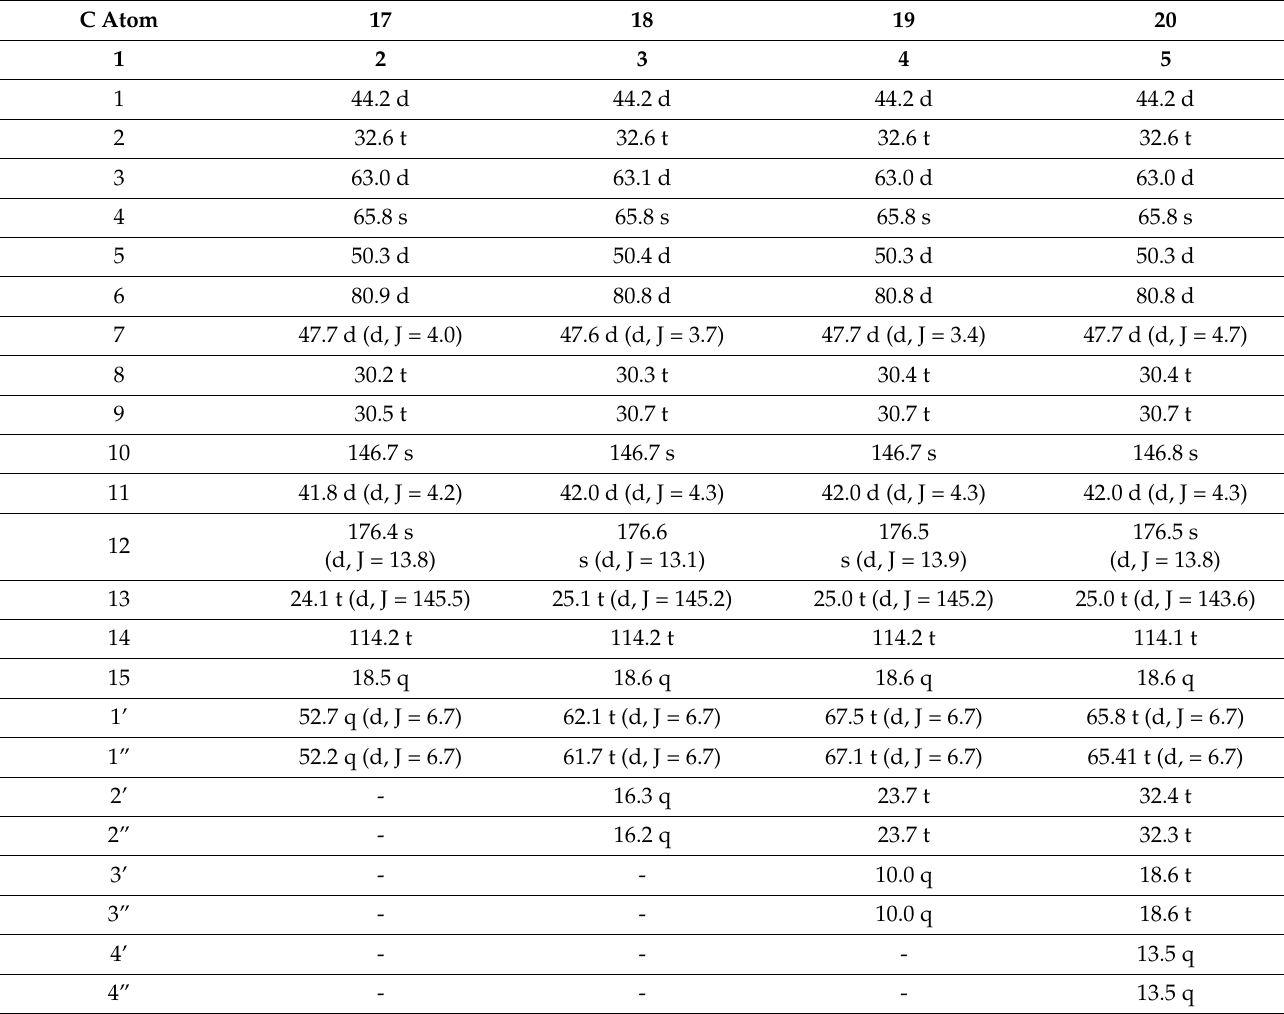
Table 4. 13 C NMR spectra data for derivatives 17 – 20 (127.76 MHz, CDCl 3 , δ , ppm) (P,